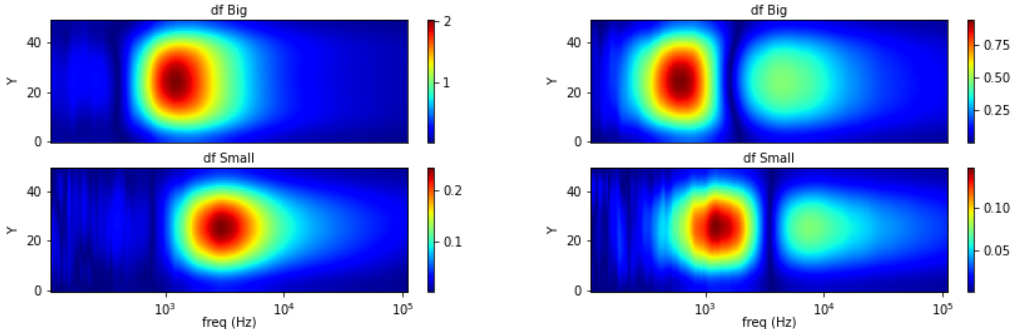
Figure 19. Z ( left ) and θ ( right ) spectral gradient (df) size variations.